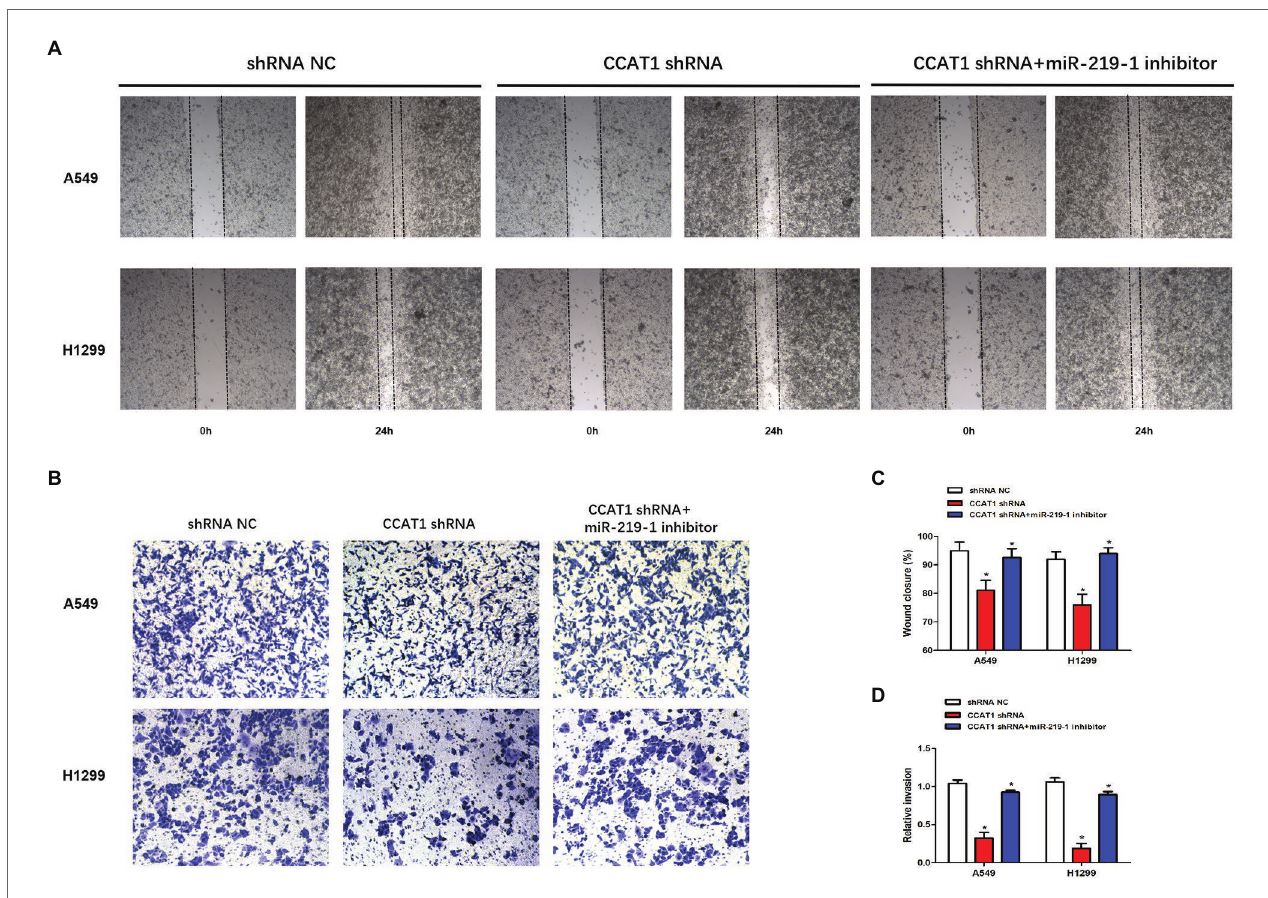
FIGURE 3 | CCAT1 knockdown suppresses the migration and invasion of LAD cells. (A,C) The effect of CCAT1 knockdown on cell migration determined by the wound-healing experiment. Pictures were taken at 0 and 24 h. (B,D) The effect of CCAT1 knockdown on cell invasion determined by the Transwell invasion assay. * p <